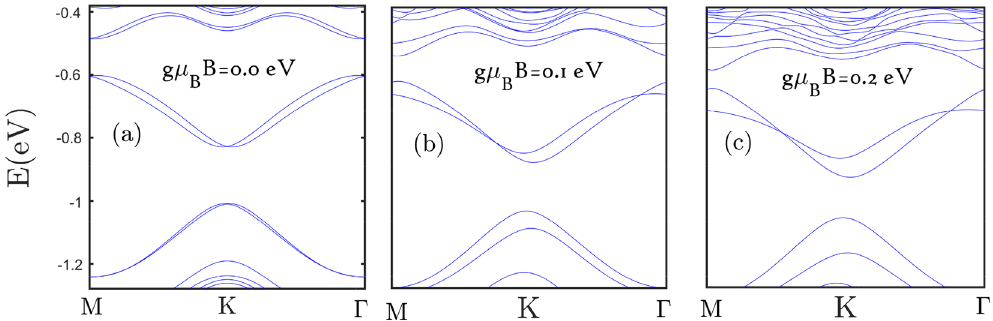
Figure 12. The electronic band structure of MoS 2 layer in the direction of M-K- Ŵ into the first Brillouin zone in the absence of strain parameter with various magnetic fields, namely g µ B B